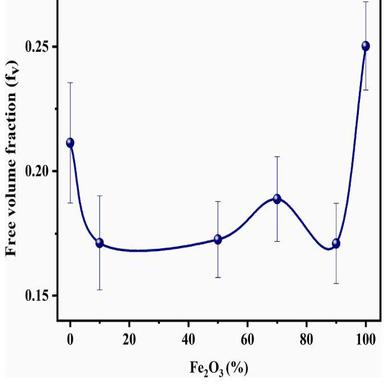
The free volume fraction versus the percentage Fe2O3 concentration in